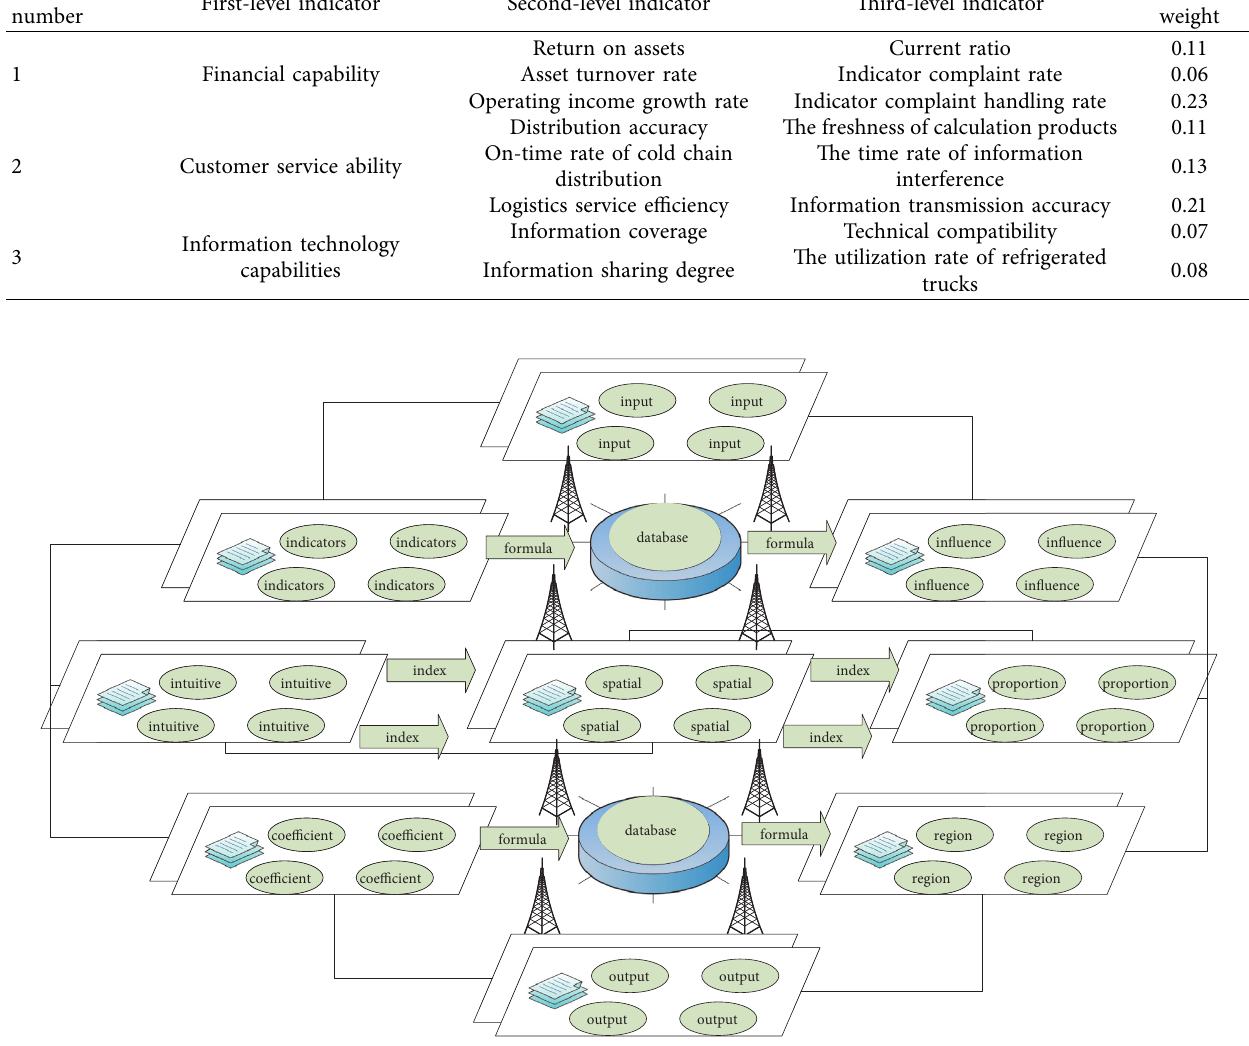
Figure 3: Quantification framework of input-output